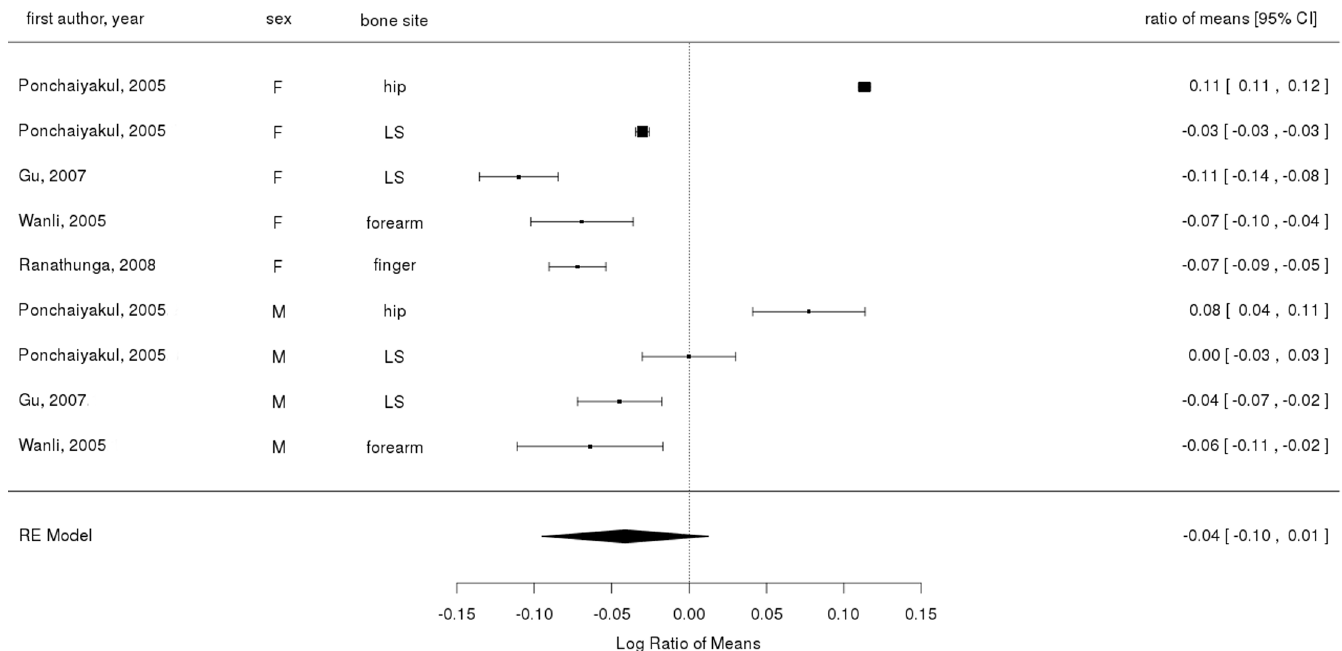
Fig 3. Ratio of means and 95% confidence interval for comparing bone mineral content or density in urban and rural populations in low and middle income countries. Symbol sizes are proportional to sample sizes. The overall effect size was derived from a random-effects model. LS: lumbar spine. WB: whole body. F: female. M: